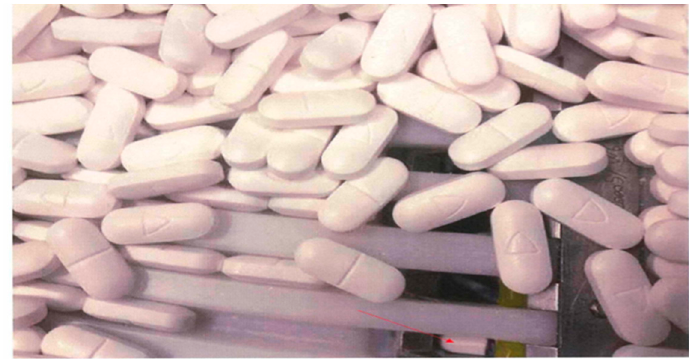
Figure 11. Tablet feed chute blockage (Cross-sectional view).